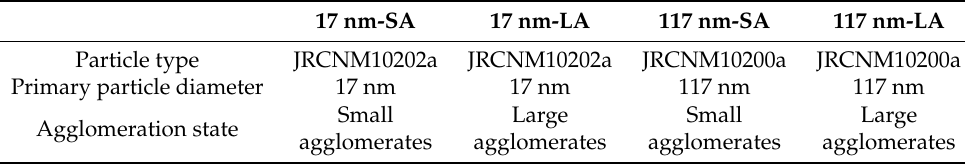
Table 1. Nomenclature of TiO 2 agglomerate